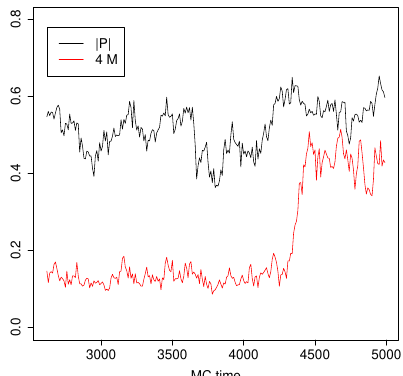
Figure 17. Full BMN model: monte Carlo history of | P | and M for N = 24 , L = 24 , µ = 1 . 5 , T = 0 . 43 . The system is initially in the deconfined trivial background and tunnels to a fuzzy-sphere background around trajectory 4500.